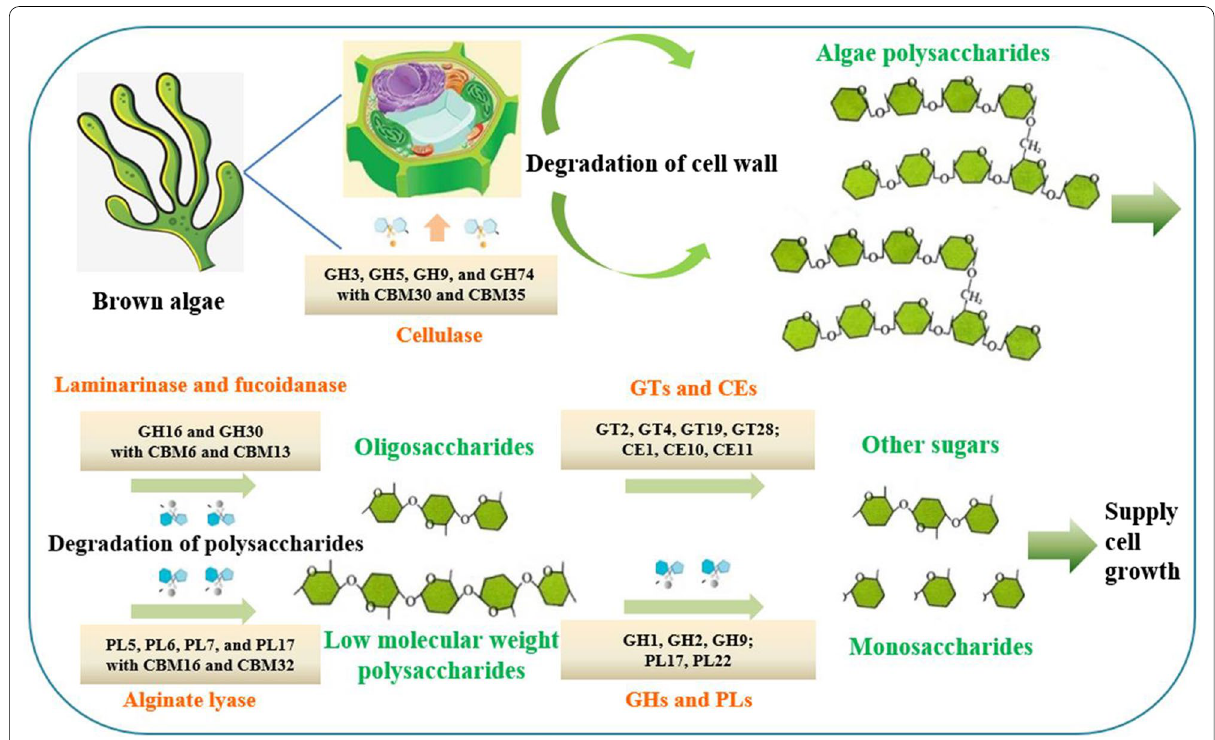
Fig. 7 Proposed degradation process of brown algae polysaccharides by Microbulbifer sp.